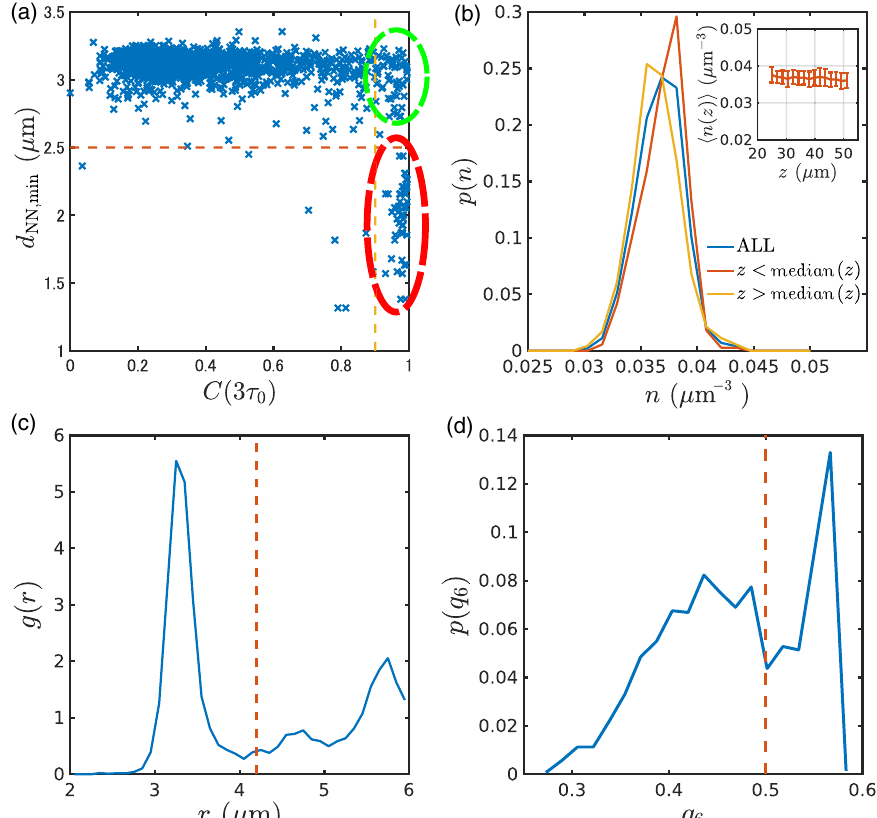
FIG. 7. Static properties of dense, partially crystalline sediment of core-shell OCULI particles. (a) Minimum distance to neighboring particles as a function of C ð 3 τ 0 Þ . Particles arrested by frictional interactions are indicated by the upper green dashed circle. Particles arrested due to dimerization with other particles during the growth of the shell are shown by the lower red dashed circle. These particles are omitted from the analysis. (b) Histogram of local volume fraction ϕ for particles below and above the median z position, as well as the distribution for all particles in the ROI. There is a small variation, but both populations contain a wide range of ϕ . Inset: average ϕ as a function of z . There is a gentle decrease with height, as expected in a sediment, but the variation is very small. (c) Radial distribution function. The threshold used for detecting nearest neighbors is given as a dashed line. (d) Distribution of q 6 over the whole ROI. The threshold used to separate crystalline and noncrystalline particles is given as a dashed line.